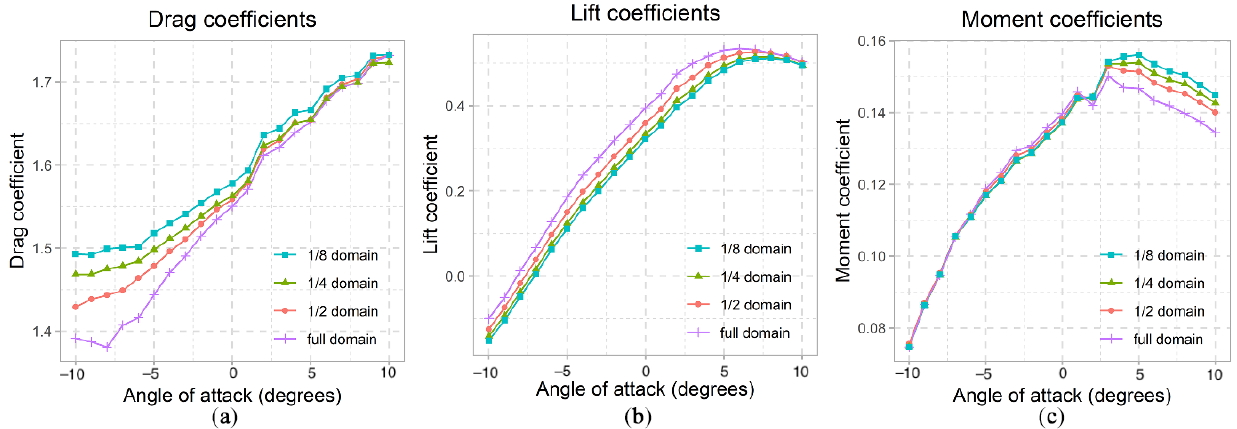
Figure 18. Comparison of aerodynamic coefficients in the domain sensitivity study: ( a ) Drag coefficients: ( b ) Lift coefficients; ( c ) Moment coefficients.